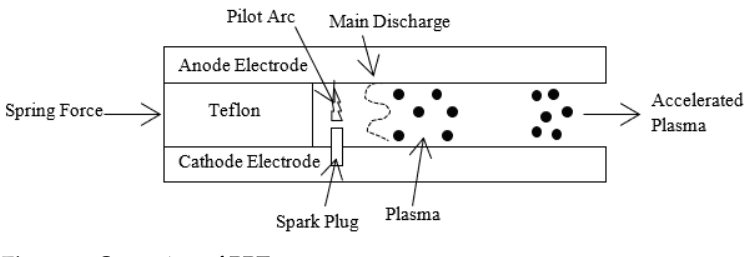
Figure 2. Operation of PPT.